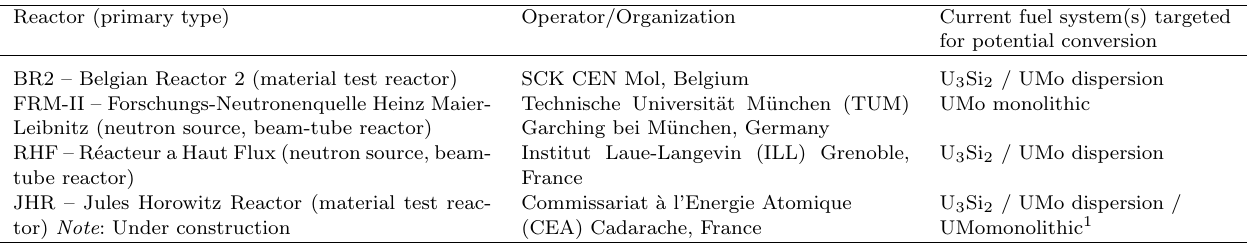
Table 1. European HPRRs, operators, and their target fuel system(s) for conversion.